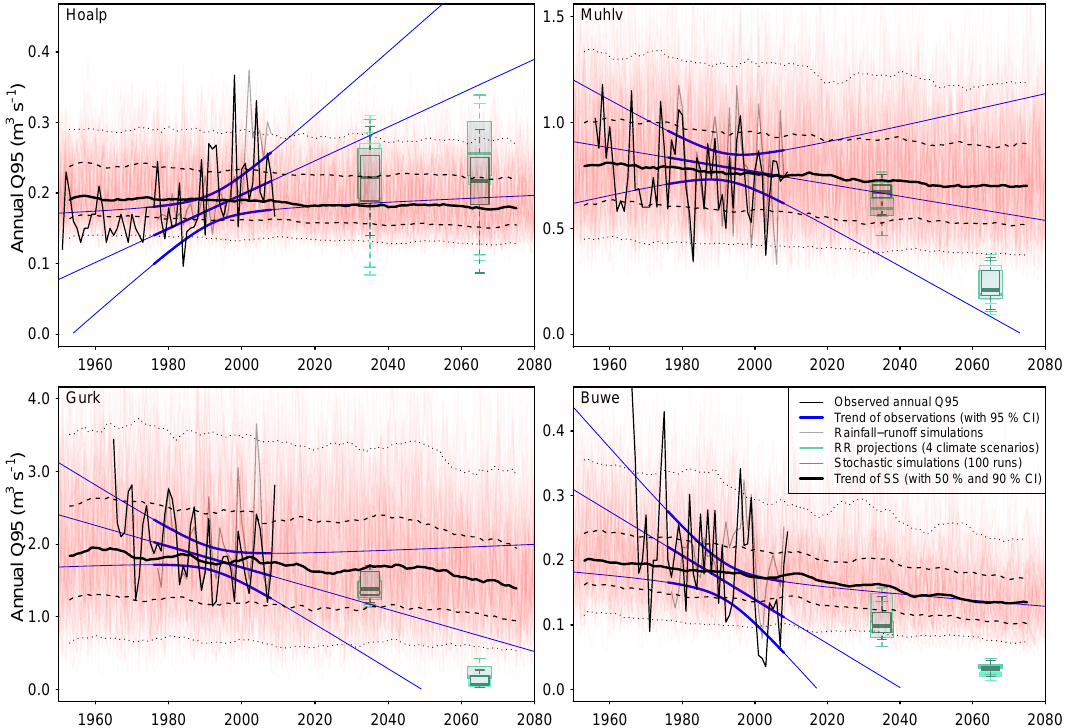
Figure 10. Three-pillar projections of annual Q 95 low flows for the Hoalp, Muhlv, Gurk and Buwe catchments. Black lines refer to observed annual Q 95 . Pillar 1: extrapolation of observed low-flow trends (blue) and 0.95 level confidence bounds (blue curved lines); bold/thin parts refer to observation/extrapolation period. Pillar 2: simulations in the observation period (grey line), and climate projections and runoff mod- elling for 2021–2050 and 2051–2080 (box plots, shades of green indicate different climate scenarios, range of box plots indicates different parameters of the hydrological model). Pillar 3: extrapolation of stochastic rainfall characteristics and runoff modelling (100 realisations, red lines) with 0.50 level (black dashed lines) and 0.90 level (black dotted lines) confidence